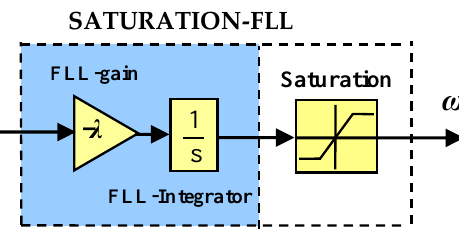
Figure 4. FLL with a saturation block.